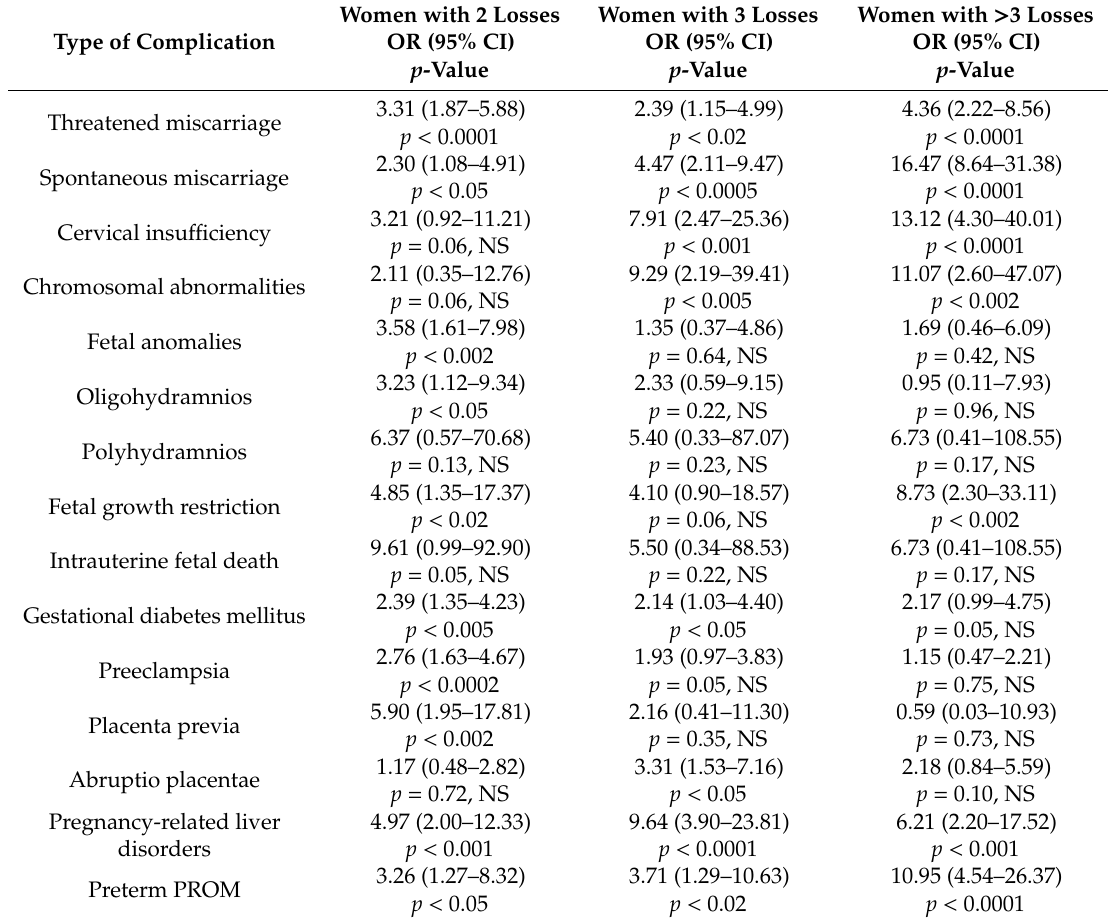
Table 4. Risk of pregnancy complications in women with RPL stratified according to the number of previous losses. The ORs have been calculated for each group of women vs. controls.